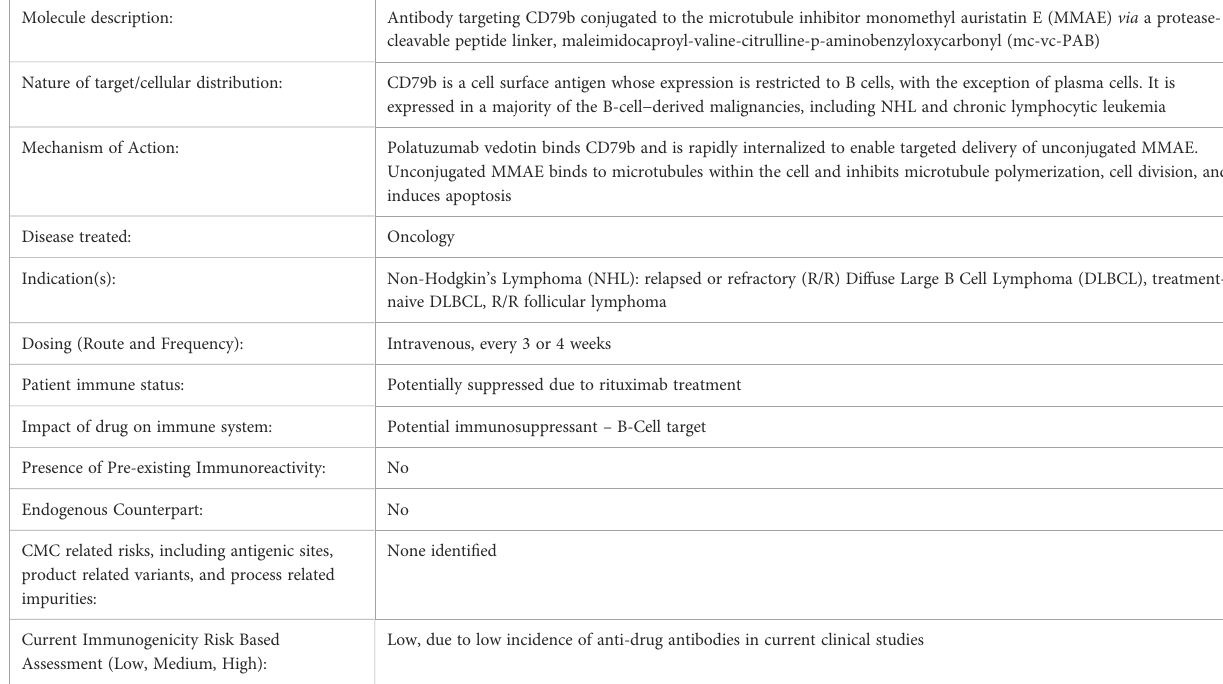
TABLE 1 Immunogenicity risk-based assessment. Molecule